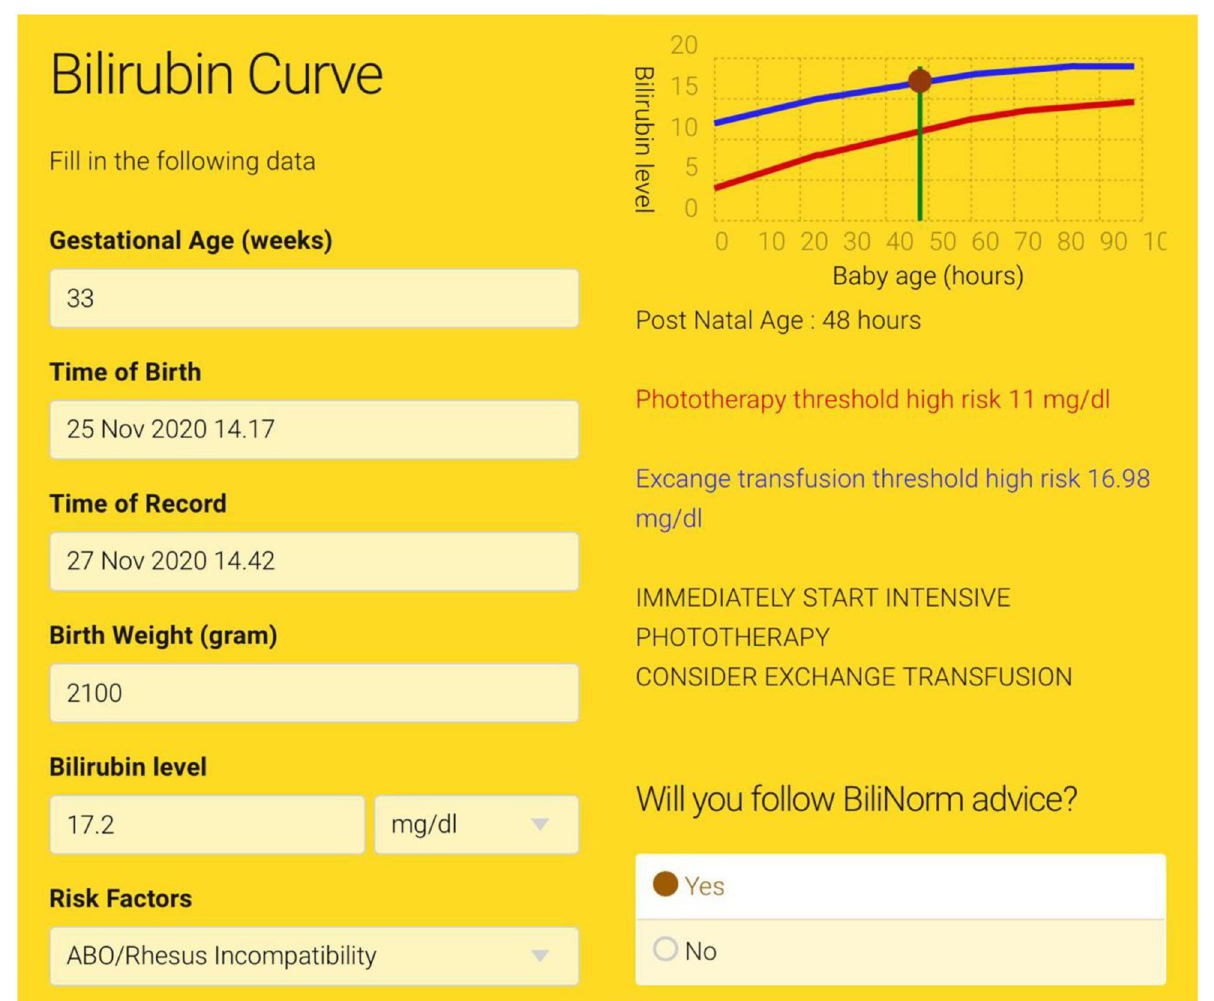
[8], where this penetration rate might be higher among healthcare workers population consid- ering them as a more well-educated group. The BiliNorm application algorithm is depicted in Fig 1. When opening the BiliNorm application, users have to fill in the following patient data: ges- tational age (weeks), date and time of birth, date and time of record, birth weight (g), TSB level (mg/dL or μ mol/L) as well as risk factors (Fig 2A). The risk factors incorporated in this tool are adapted from the AAP guideline [9] and include ABO/Rhesus incompatibility, haemolysis (G6PD deficiency or spherocytosis), other illness (asphyxia, infection) and hypoalbuminemia ( < 30 mg/L). When ‘no risk factors’ is filled in, the case is considered as uncomplicated hyper- bilirubinemia. When ‘unknown risk factors’ is filled in, the patient is categorised as having risk factors (other than those listed or not being able to check the risk factors). After filling in these data, the actual TSB level of the infant is shown in the TSB nomogram that displays the